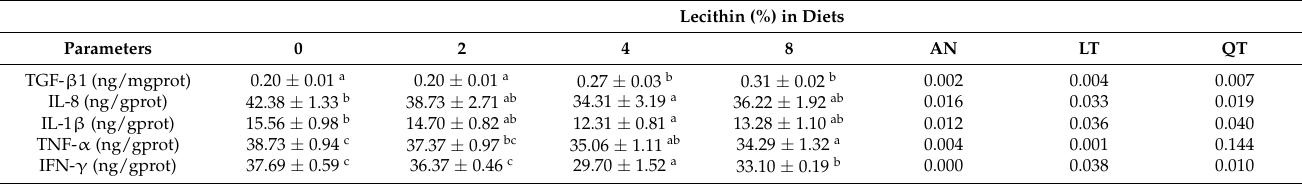
Table 7. Effects of dietary soybean lecithin on the anti-inflammatory and pro-inflammatory cytokines in the liver of largemouth bass. Lecithin (%) in Diets